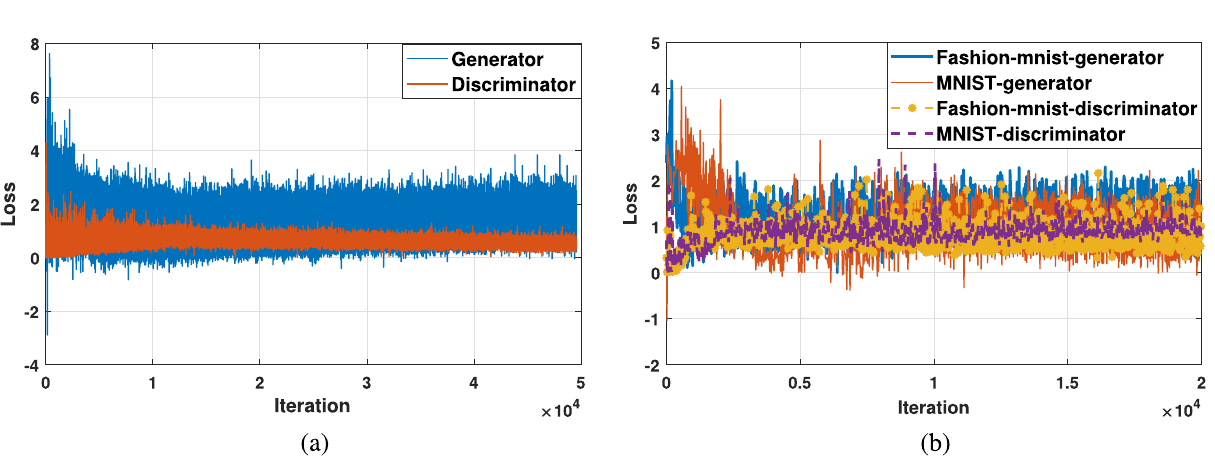
Figure 6. Comparison of AWCA-GAN loss on three datasets of OPT_Aircraft-7, MNIST and Fashion-MNIST over training stages. ( a ) Loss curves of generator and discriminator on OPT_Aircraft -7 dataset over training iteration. ( b ) Loss curves of generator and discriminator on MNIST dataset and Fashion-MNIST datasets over training